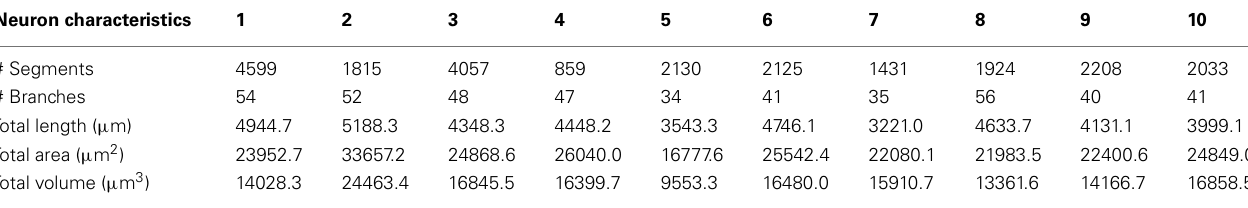
Table 1 | Gross neuron statistics for each of the ten reconstructions created by the participants.